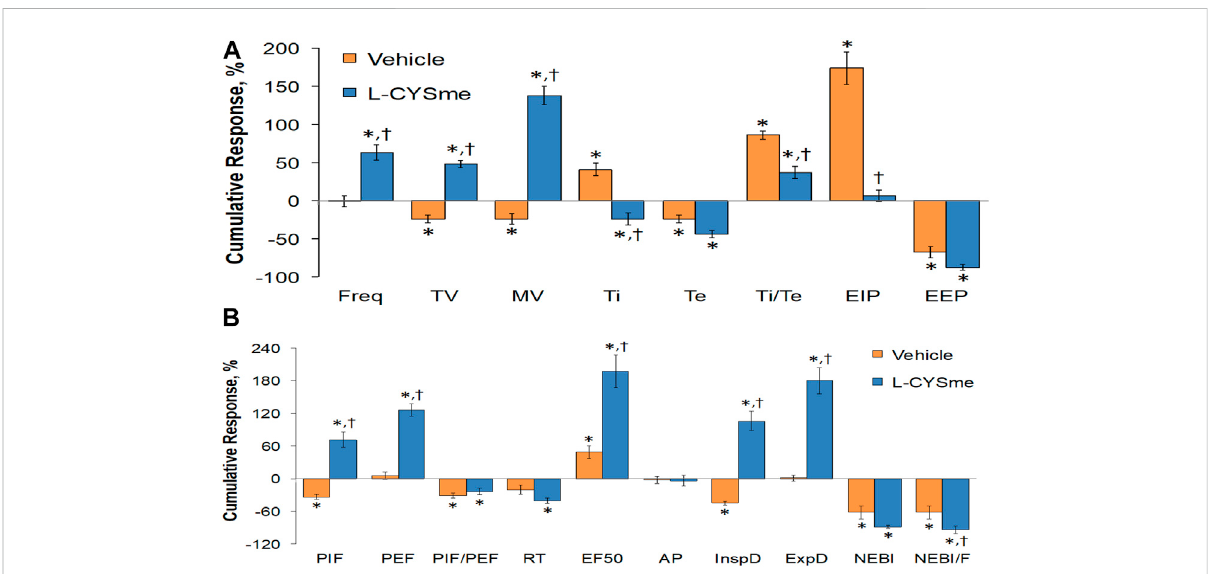
FIGURE 9 Cumulative changes in ventilatory parameters recorded over the 60-min period that followed the second injection of vehicle or L-cysteine methyl ester (L-CYSme, 500 μ mol/kg, IV) in rats injected with morphine (10 mg/kg, IV). Panel (A) frequency of breathing (Freq), tidal volume (TV), minute ventilation (MV), inspiratory time (Ti), expiratory time (Te), Ti/Te, end inspiratory pause (EIP), and end expiratory pause (EEP). Panel (B) peak inspiratory fl ow(PIF),peakexpiratory fl ow(PEF),PIF/PEF,relaxationtime(RT),expiratory fl owat50%ofexpiredtidalvolume(EF 50 ),apneicpause (AP), inspiratory drive (InspD, TV/Ti), expiratory drive (ExpD, TV/Te), non-eupneic breathing index (NEBI), and NEBI/freq (NEBI/F). Data are presented as mean ± SEM. There were 6 rats in each group. * p < 0.05 signi fi cant difference from Pre values. † p < 0.05, signi fi cant difference between L-CYSme versus vehicle.